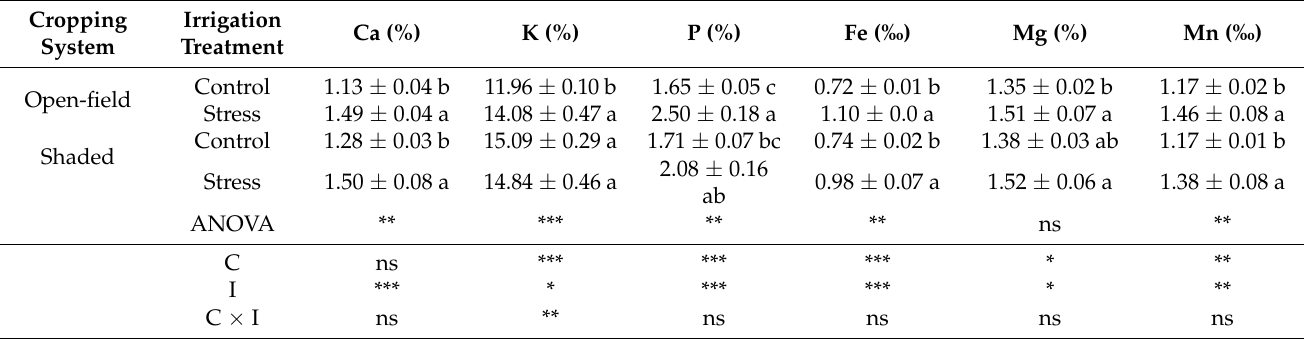
Table 6. Mineral content: Ca, K, P, Fe, Mg, and Mn in lime juice from control and stressed trees grown in open-field and shaded